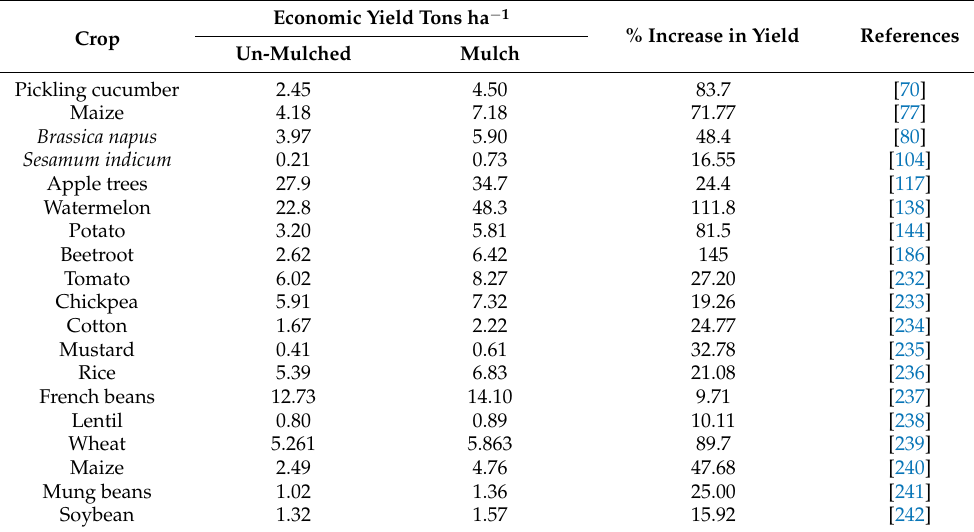
Table 6. The impact of mulching on yield and crop